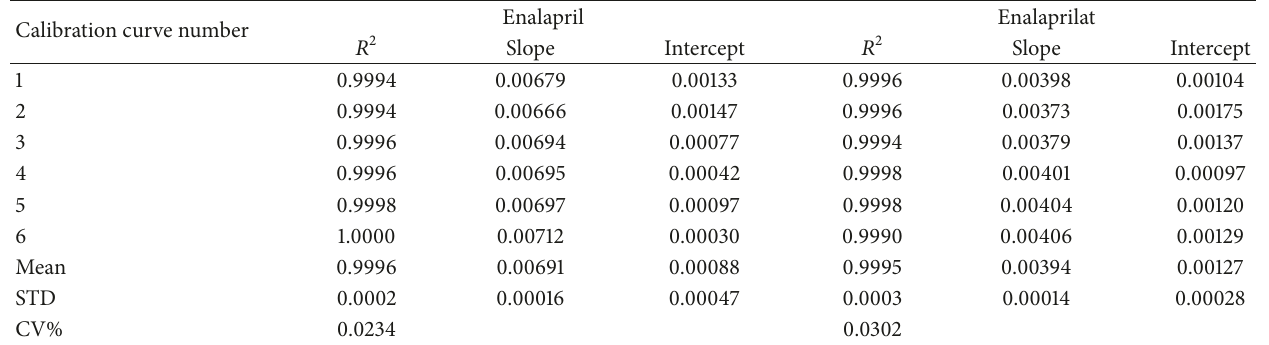
Table 2: Calibration function parameters during method validation by using LC-MS/MS.